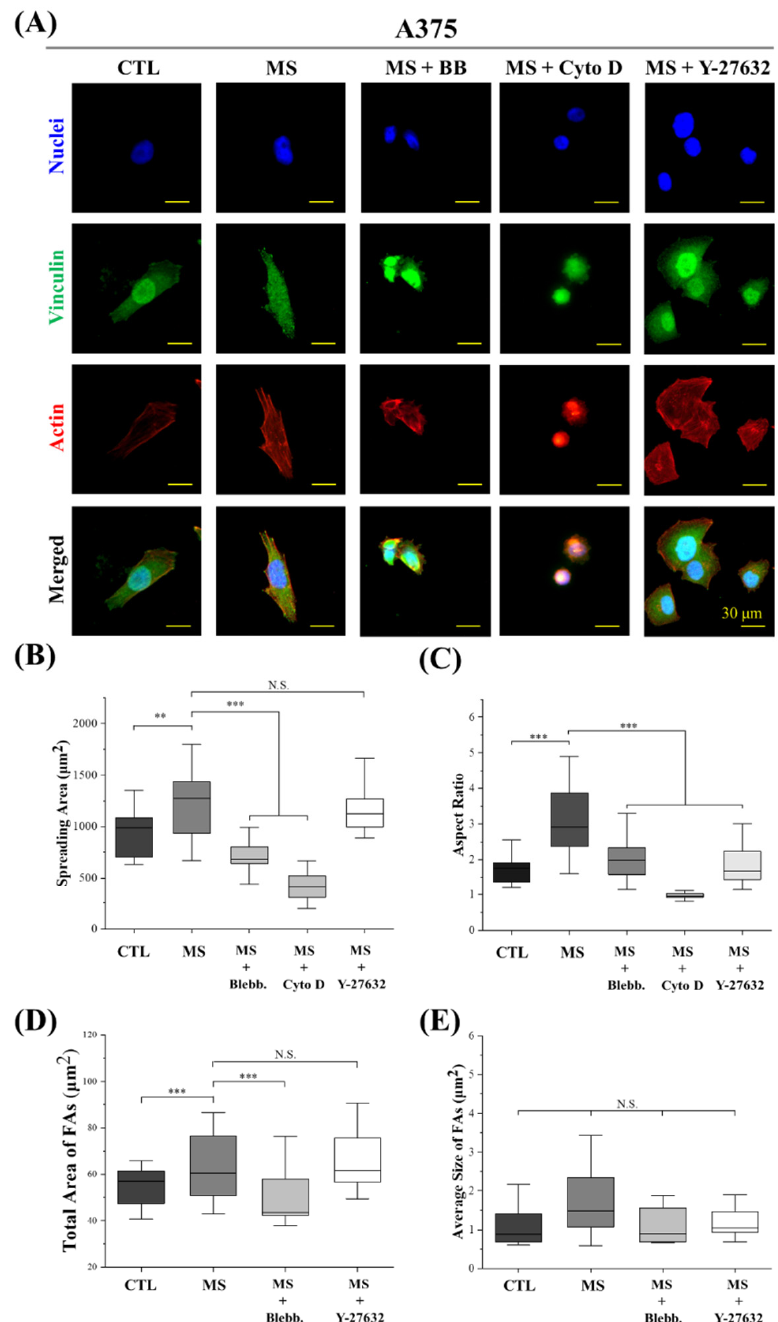
Figure 6. Influence of cyclic straining and inhibitors on the morphogenesis of A375 cells. ( A ) Repre- sentative fluorescent images of actin, vinculin, and nuclei-stained A375 cells. ( B ) Spreading area of B16 cells ( n > 30). ( C ) Aspect ratio of A375 cells ( n > 30). ( D ) Total size of focal adhesions in A375 cells. ( n > 30). ( E ) Average size of focal adhesions in B16 cells ( n > 30). ** p < 0.01, *** p < 0.001, N.S.: Not